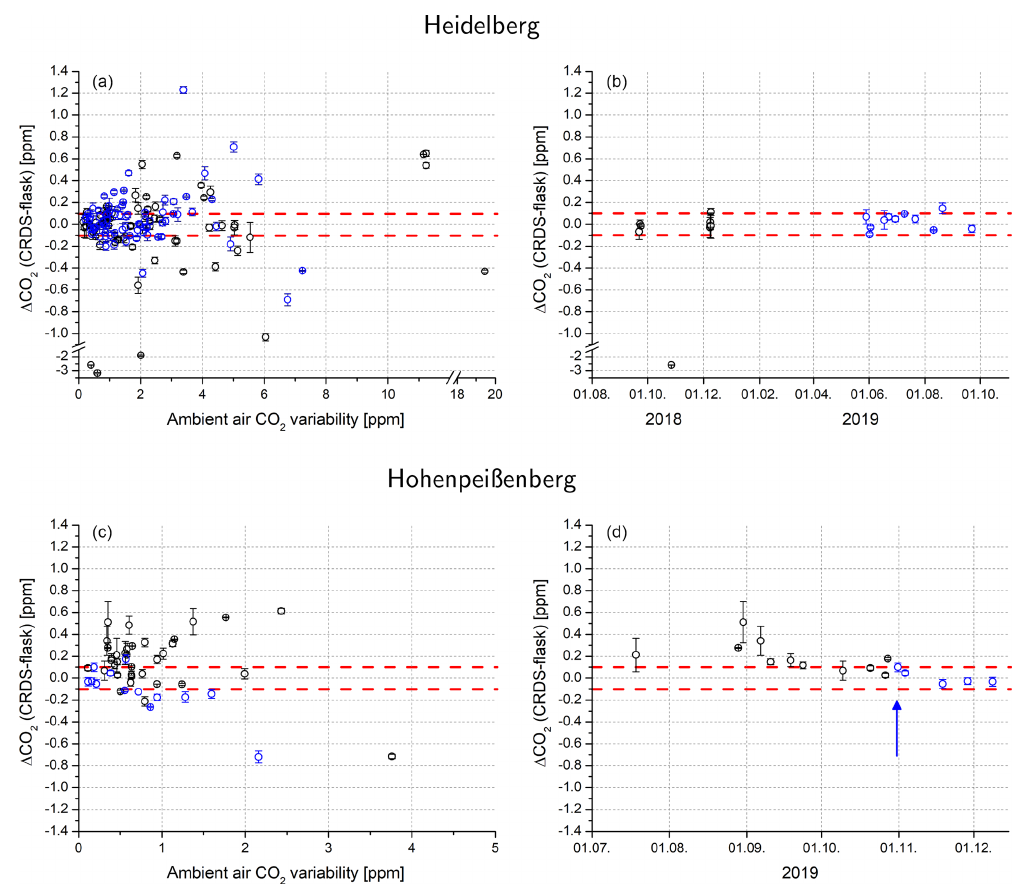
Figure 3. In situ minus flask CO 2 results obtained with the 1 /t flask flushing method to obtain a real hourly mean sample. (a–b) Results from Heidelberg; flasks from the second comparison period are marked in blue. (a) Results for all comparison flasks plotted versus ambient variability. (b) Temporal development of the in situ minus flask measurements for ambient air CO 2 variability < 0 . 5 parts per million – ppm. All differences in the second comparison period lie within the required ± 0 . 1ppm compatibility range. No sampling was performed between February and May 2019. (c–d) Same as (a) and (b) but for results from Hohenpeißenberg. Flasks from the comparison period after 30 October 2019 (the date when the leak was sealed) are plotted in blue. (d) Temporal development of the in situ minus flask measurement for ambient CO 2 variability < 0 . 5ppm. All five differences, after sealing the leak on 30 October 2019 (blue arrow; blue dots), lie within the required ± 0 . 1ppm compatibility